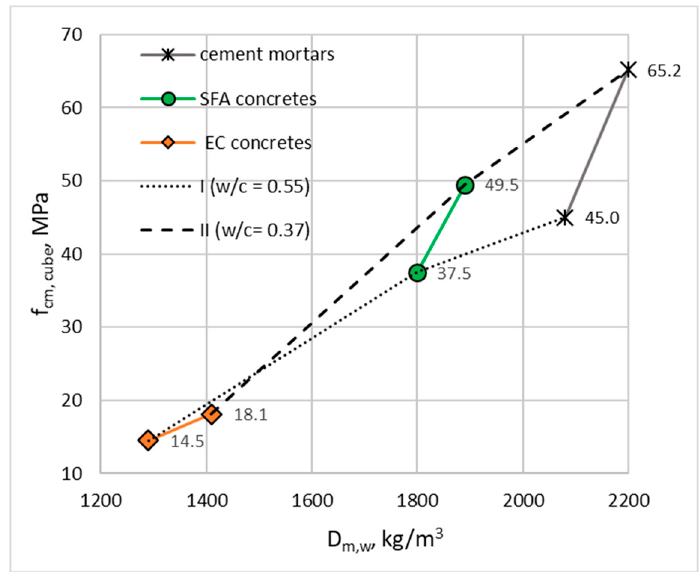
Figure 7. The effect of the application of different cement mortars as matrices for lightweight concretes with sintered fly ash (SFA) and expanded clay (EC) aggregates on their density and strength (wet condition).